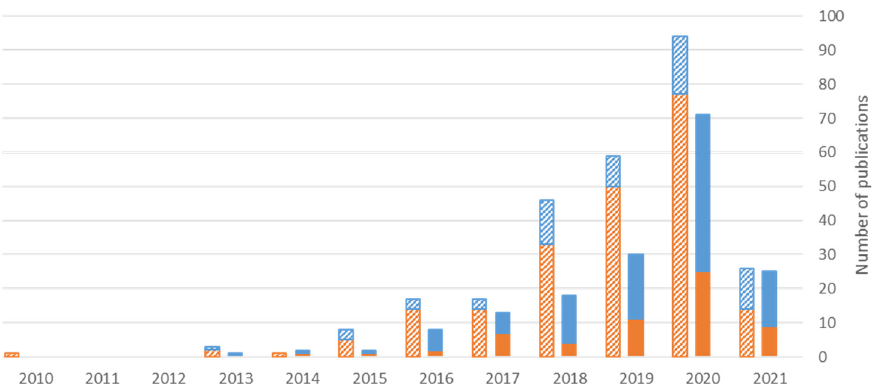
Figure 1. The number of original research articles published on freshwater (full-color) and marine (striped) species in laboratory (blue) and field (orange) studies.